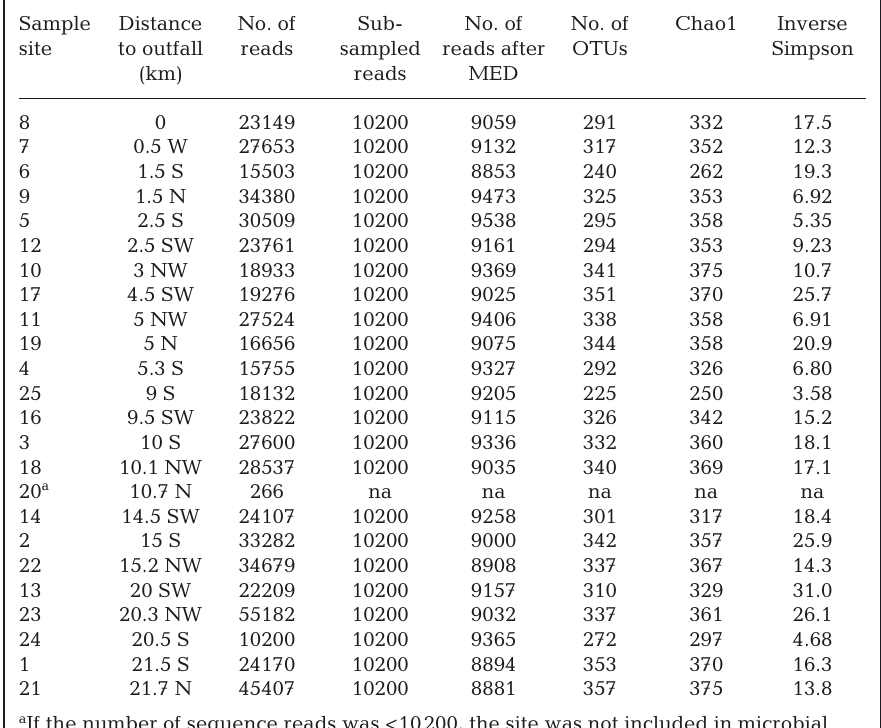
Table A1. Summary of sampling sites, sequence reads, and alpha diversity metrics. MED: minimum entropy decomposition, na: not applicable, OTU: operational taxonomic